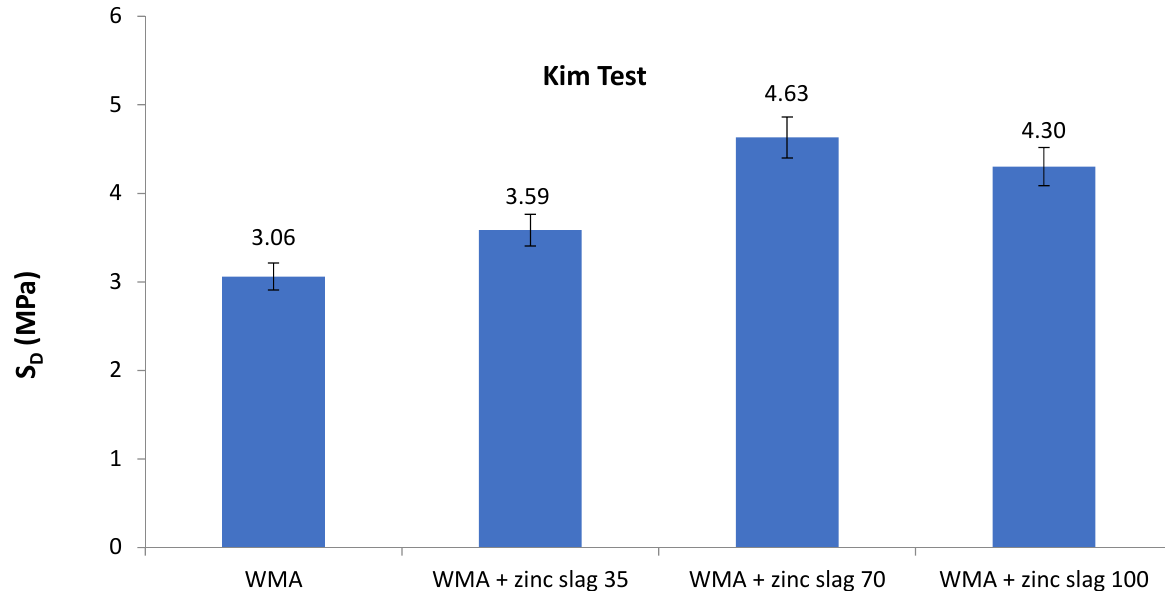
Figure 10. Deformation strength test values for different samples.